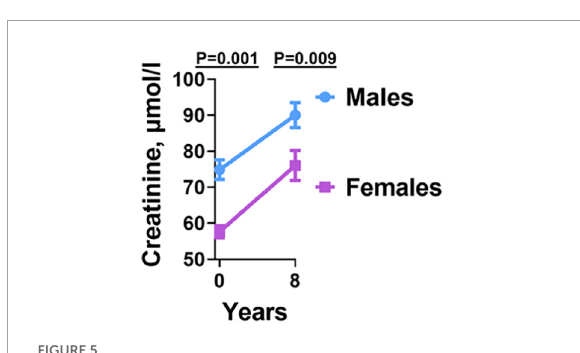
FIGURE5 Creatinine levels before and after antiretroviral therapy in males and females. Males had higher Creatinine levels at both baseline and final year compared to